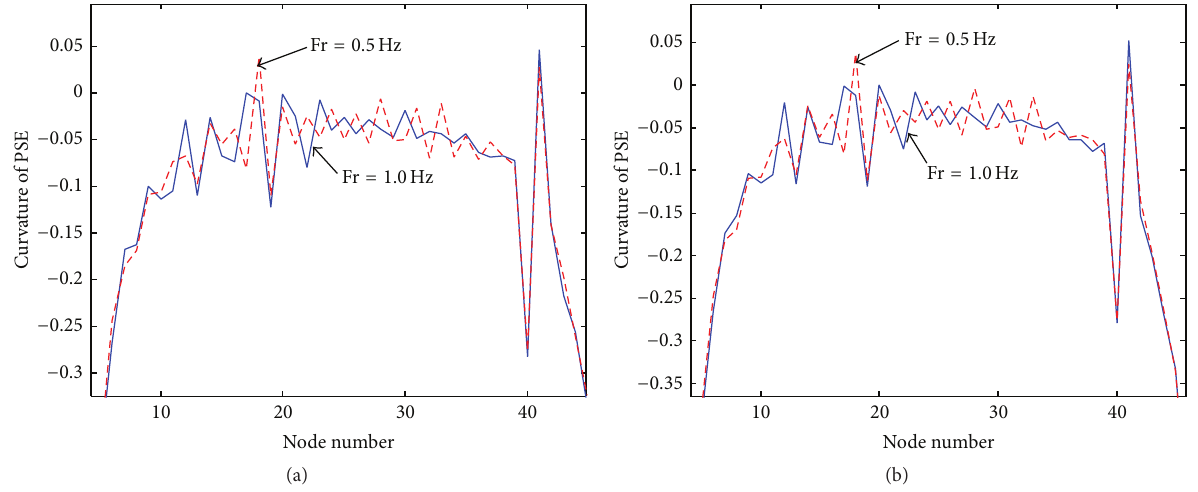
Figure 7: PSE curvature: (a) rectangular window, 50% overlap, (b) Hamming window, 50% overlap.